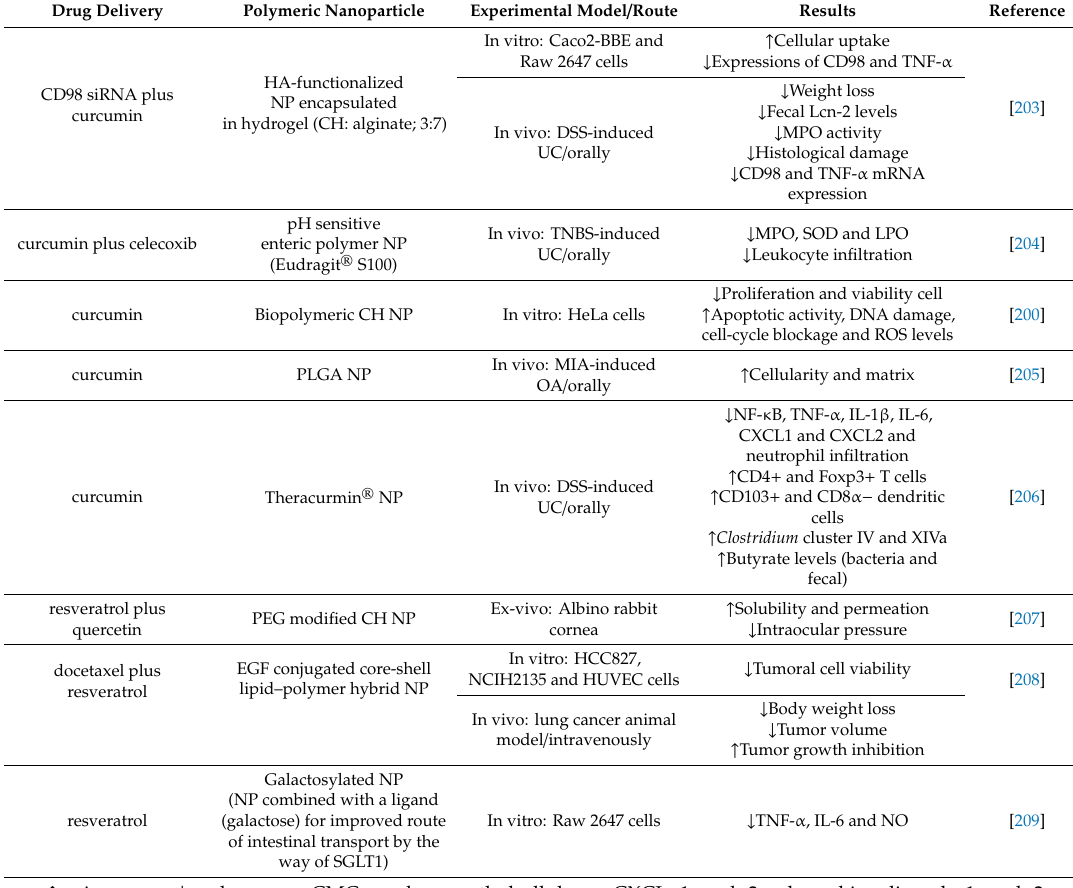
Table 4. Development and use of nutraceutical-loaded polymeric nanoparticles on di ff erent pathologies. Drug